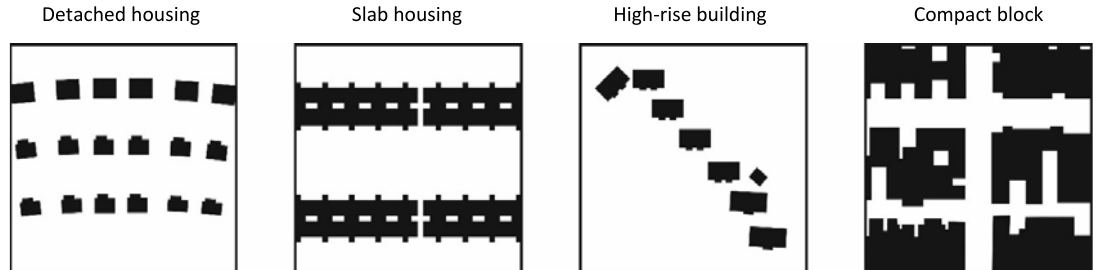
Fig. 4: Figure ground map of the urban morphotypes of Khorramshahr